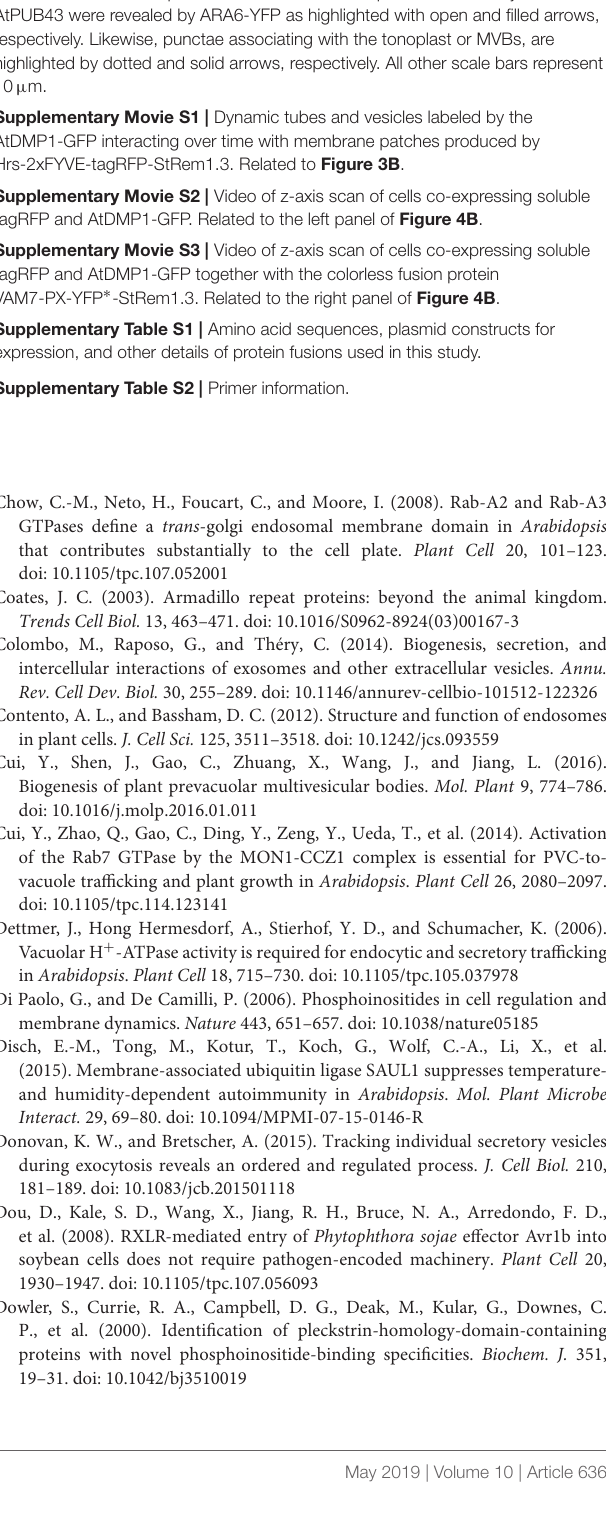
Supplementary Figure S12 | Distribution of the fluorescently tagged full-length AtPUB43 in N. benthamiana leaf cortical cells during pathogen infection. (A) Cortical cells expressing YFP-tagged AtPUB43 were infected by GFP-tagged oomycete P. capsici (artificially represented by the red color). Top panel: tile-scan imaging showing the changing distribution of YFP-AtPUB43 on the PM associated with the progress of P. capsici infection. Scale bar in this panel represents 50 µ m. Lower panel: details of the distribution of YFP-AtPUB43 in necrotic (outlined by gray box), infected (outlined by purple box) and uninfected cells (outlined by blue box). (B) Distribution of ARA6-YFP compared to YFP-AtPUB43 in uninfected and infected cells. The tonoplast- and MVB-associated patches formed by YFP- AtPUB43 were revealed by ARA6-YFP as highlighted with open and filled arrows, respectively. Likewise, punctae associating with the tonoplast or MVBs, are highlighted by dotted and solid arrows, respectively. All other scale bars represent 10 µ m.